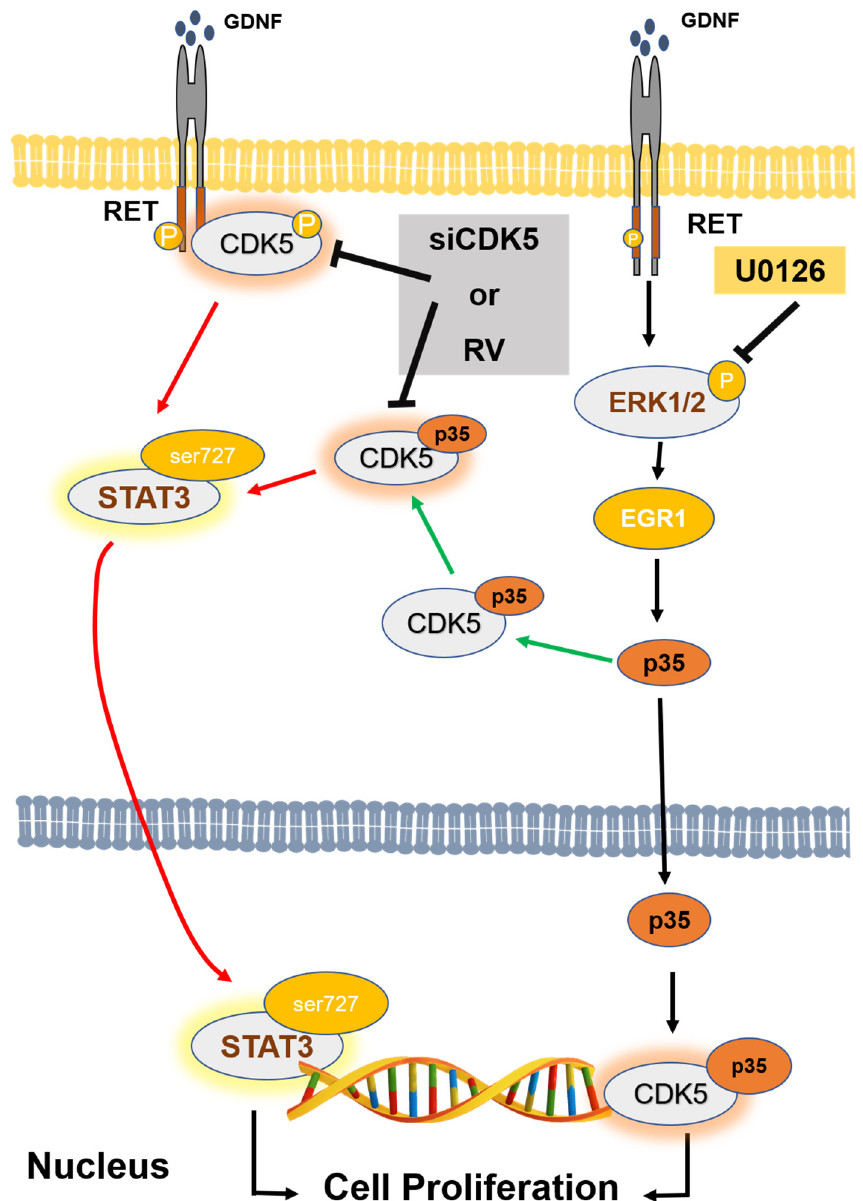
Figure 5. A schematic illustration of signaling mechanism in GDNF-induced human medullary thy- roid cancer cell proliferation. GDNF activates RET protein. Activation of RET causes phosphorylation of ERK1/2 and subsequent activation of EGR1. Active EGR1 causes nuclear accumulation of p35 that can binding and activates CDK5. Active CDK5 physically interacts with the intracellular domain of RET protein to pass through the GDNF-activated signaling cascade. Finally, CDK5 activates STAT3 by its specific phosphorylation on Ser727. This further trigger medullary thyroid cancer cell proliferation.